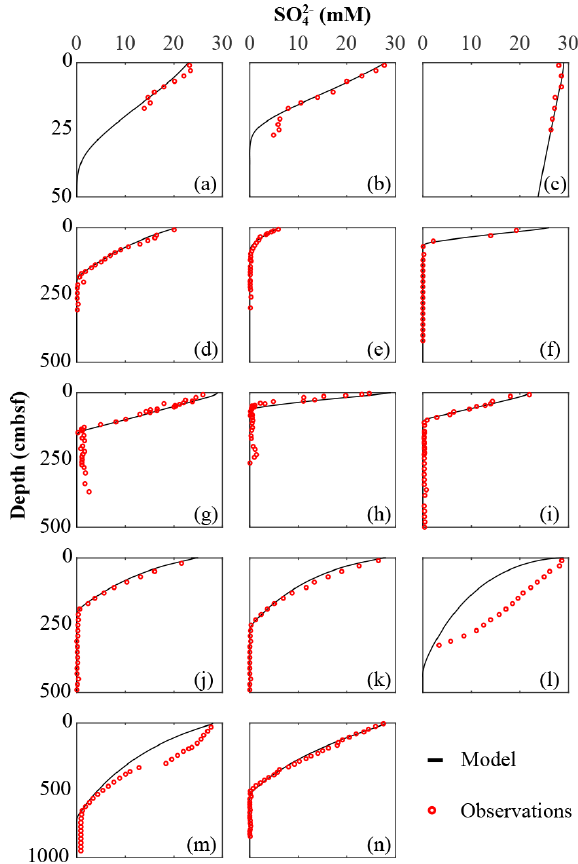
Figure 3. Sulfate data–model best fit: (a) Severn estuary; (b) Rhone pro-delta; (c) Rhone shelf; (d) Aarhus Bay; (e) Arkona Basin; (f) Helgoland mud area, North Sea; (g) Skagerrak – S10; (h) Sk- agerrak – S11; (i) Skagerrak – S13; (j) Arabian Sea – OMZ core; (k) Arabian Sea – OMZ transition; (l) Arabian Sea – below